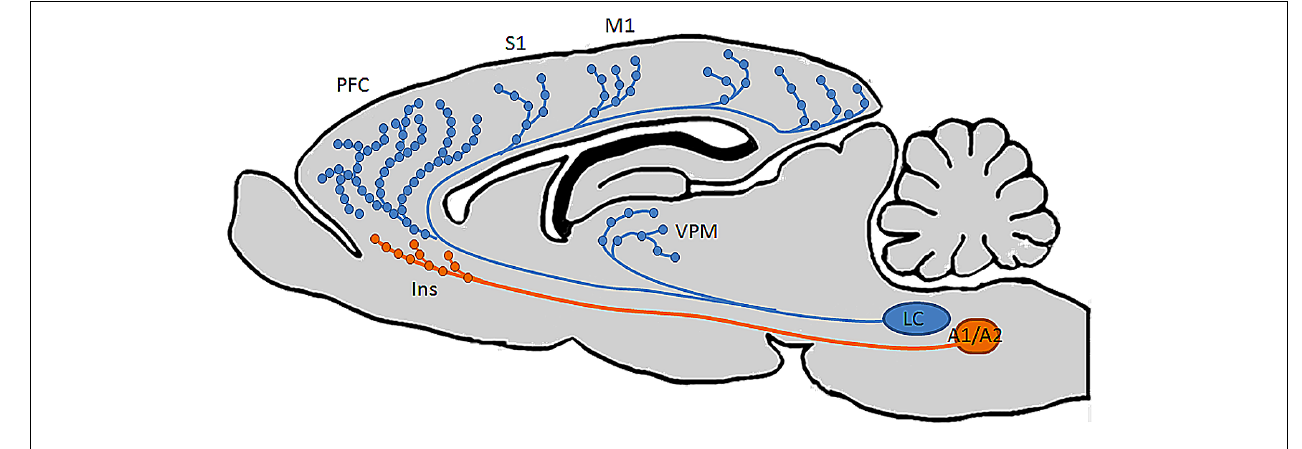
etal. (2013) also challenged the longstanding notion that LC is the sole source of NE to cortex by demonstrating the existence of NE-containing fibers in insular cortex derived from a rhombomere distinct from that in which LC develops, suggesting that this region has privileged access to autonomic and visceral information while the rest of the cortical mantle does